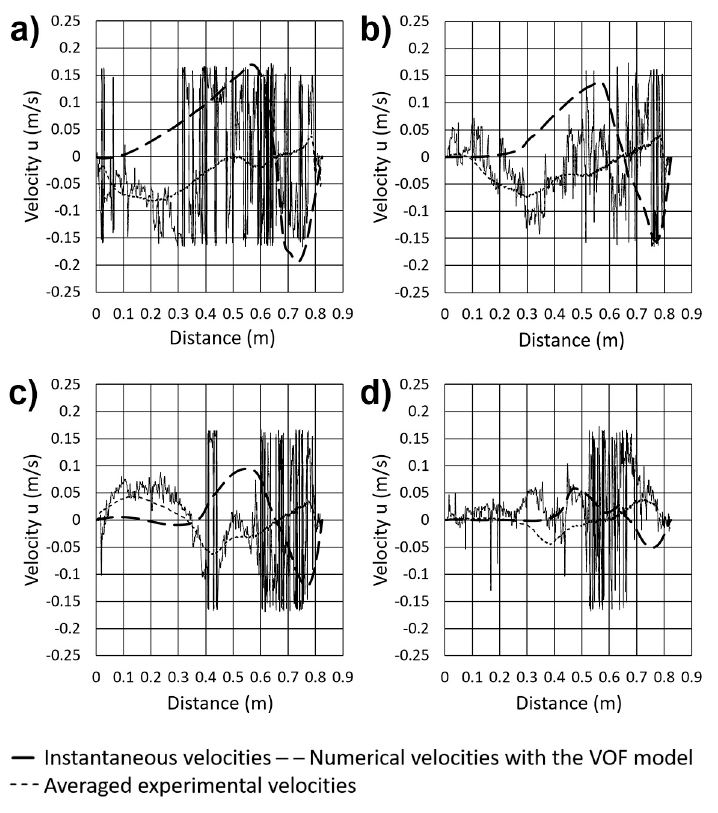
Figure 11. Measured versus simulated velocities 20 mm below the metal-slag interface for different thicknesses of the upper phase layer at a fixed gas flow rate of 1.07 × 10 − 4 m 3 /s. ( a ) 0 m, ( b ) 0.01 m, ( c ) 0.02 m, and ( d ) 0.04 m.